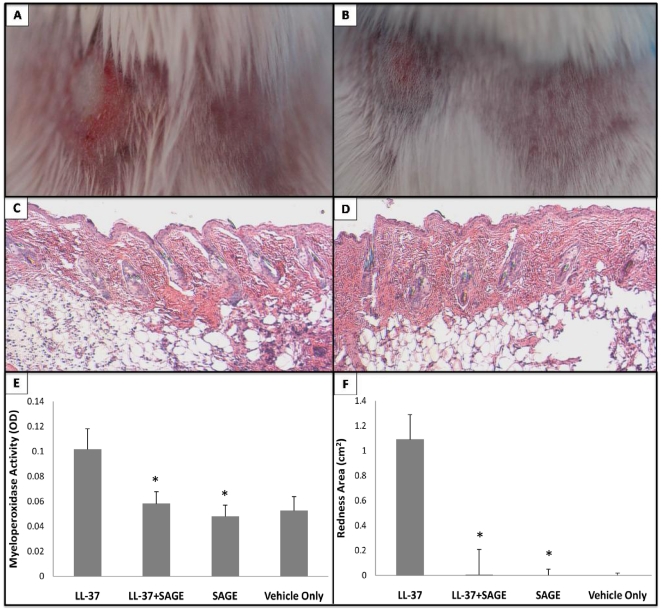
SAGE co-injection inhibits erythema and PMN infiltration from intradermal LL-37.Balb/c mice were shaved to expose an area of skin on the back. Twenty-four hours later, mice were intradermally injected with 40 µl of vehicle (nanopure water), LL-37 (at 320 µM concentration in water), SAGE GM-1111 (1,280 µM in water), or LL-37+ GM-1111 mix (peptide +4 molar equivalents of SAGE) placed intradermally into the shaved skin using a 31-gauge needle and 0.5 ml insulin syringe. Injections were repeated every 12 h thereafter. Forty-eight hours after the initial injection (four injections in total), animals were lightly anesthetized with isoflurane, the area of injected skin was photographed, the intensity of erythema was assessed as a redness score (from 1 to 5, with 5 as the most red), and the area of erythema was measured with micrometer calipers. The injected skin was then biopsied for histopathologic staining and to assess PMN infiltration through measurement of myeloperoxidase (MPO) activity. A. Gross picture of LL-37 injected skin region. B. Co-injection model of LL-37 and SAGE GM-1111. C. H&E-stained cross-sectional view of a LL-37 injected skin sample. D. H&E-stained cross-sectional view of a LL-37 mixed with GM-1111- injected skin region. E. MPO activity measurement of LL-37 injection with different treatments. F. Area of erythema from LL-37 injection. *P<0.05 vs intradermal LL-37 alone; n = 6 per group.